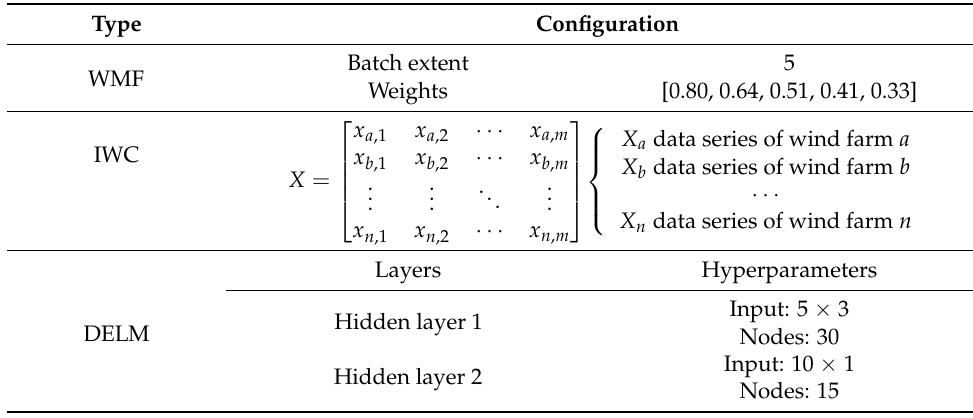
Table 1. Configuration of the proposed ensemble model IWC-DELM.